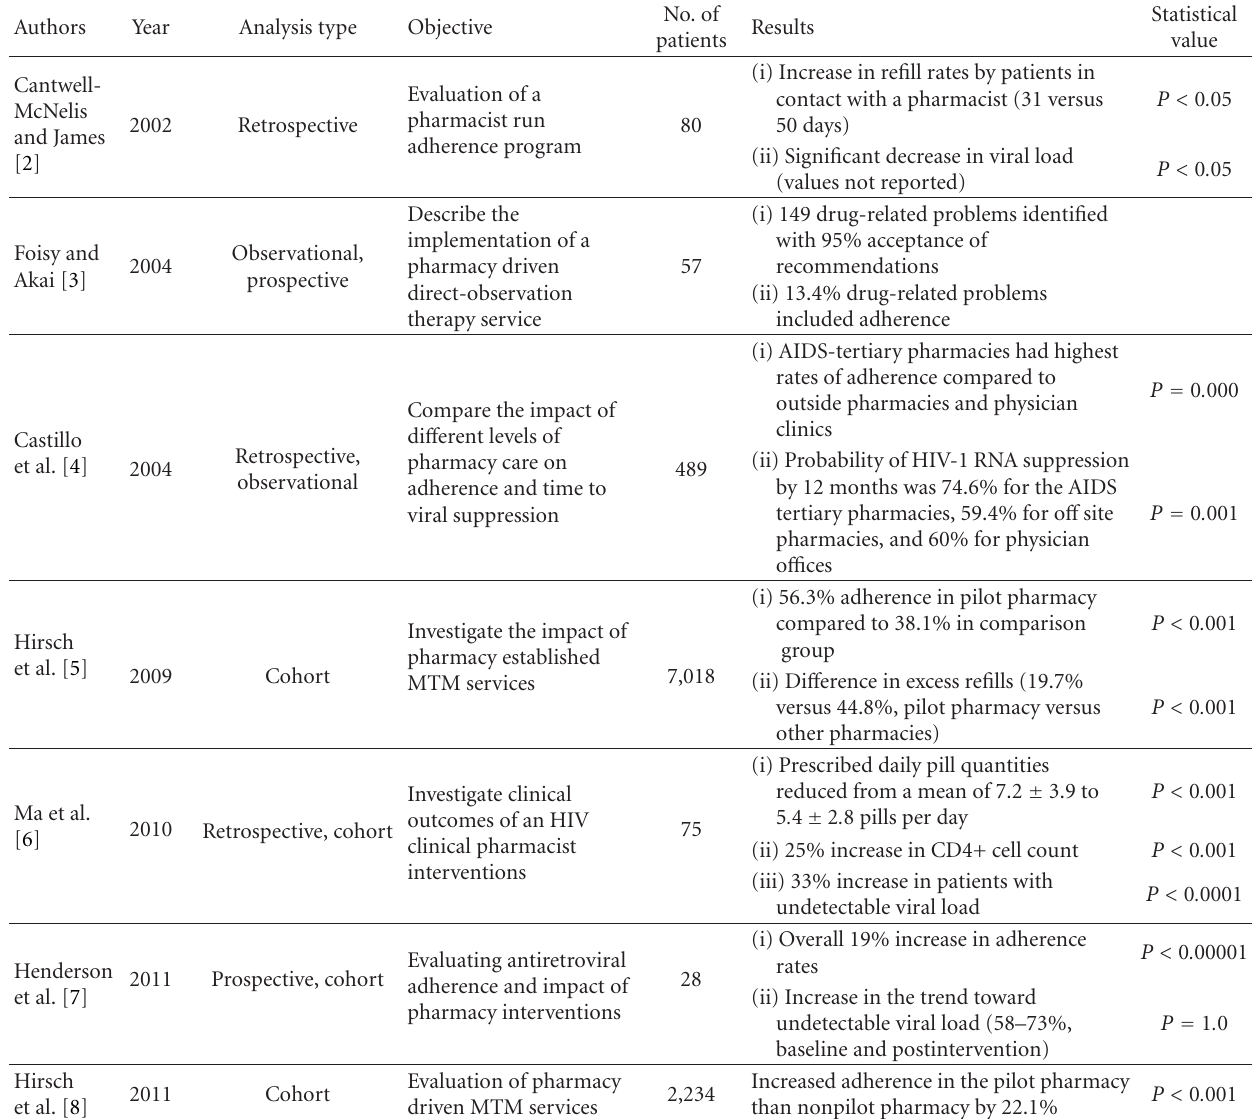
Table 1: Pharmacist impact on adherence in patients with